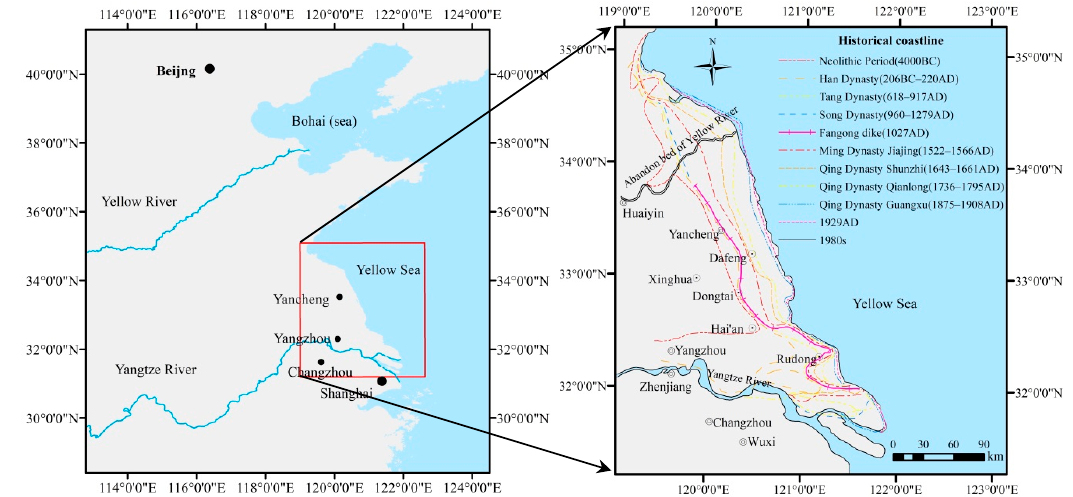
Figure 1. Coastline changes in Jiangsu Province, China [33].